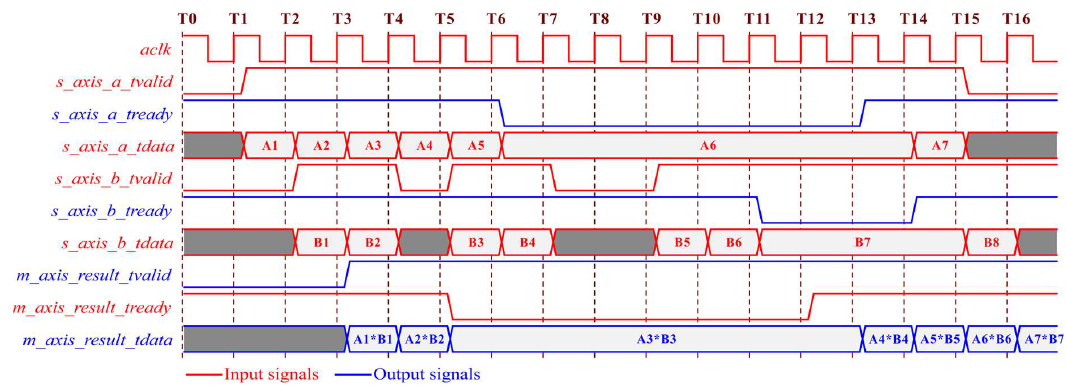
Figure 2. Waveform of the Float Point Unit (FPU) Multiply.